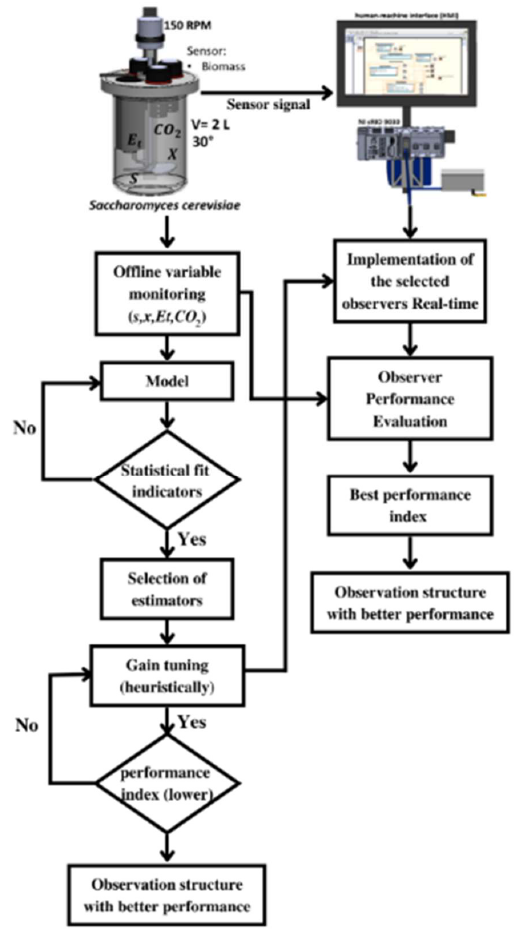
Figure 2. General scheme of the methodology.